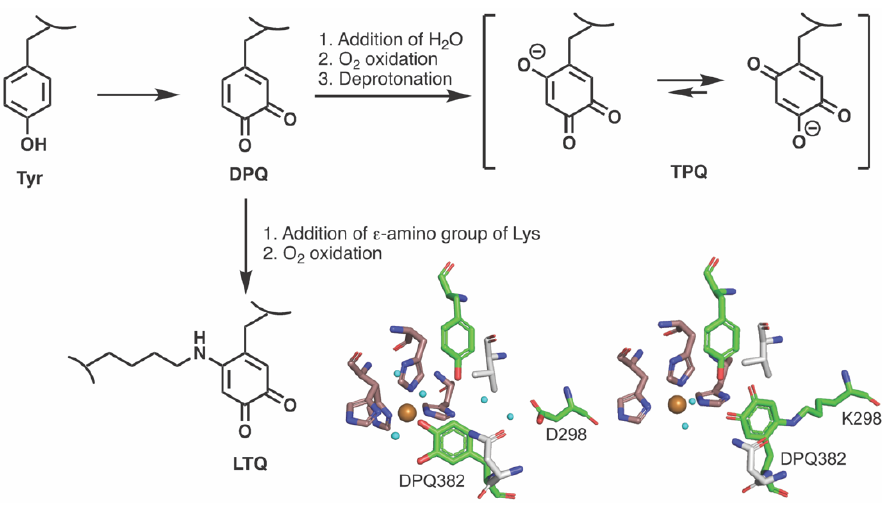
Figure 1. DPQ is proposed as a common intermediate in the biogenesis of TPQ and LTQ. 1,4-Hydration or 1,4-amination of DPQ followed by O 2 oxidation yield TPQ or LTQ. DPQ detected during biogenesis of TPQ in AGAO by X-ray snapshot analysis [7] and an LTQ-like quinone (K298 crosslinked to DPQ382) detected in D298K-AGAO [10] are also shown. DPQ382, Tyr284 (conserved Tyr) and Asp298 (active site base): in green; Cu 2+ binding site (His431-X-His433—His592): in brown; Val282 and Asn381 (walls of the wedge identified in CAOs [11,12]): in gray. In 2018, Zhang et al. reported an X-ray crystal structure of a Zn 2+ -bound precursor form (PDB: 5ZE3) of a N-terminally truncated LOXL2 at 2.4 Å resolution [13]. This is a